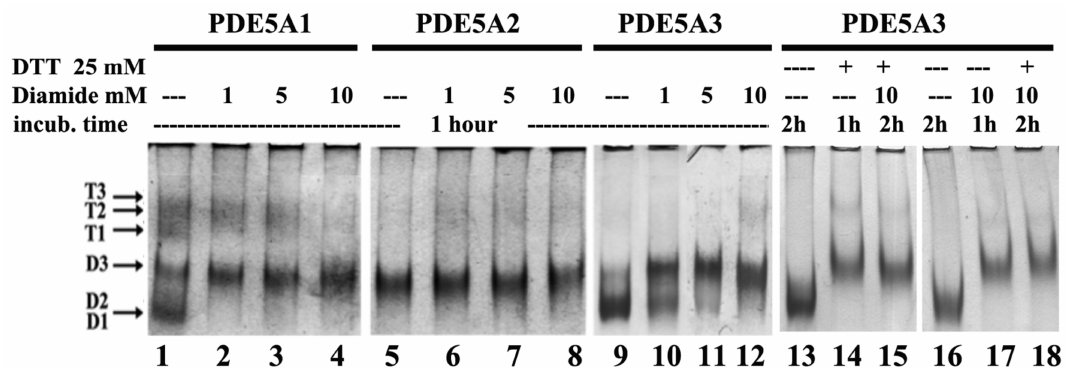
Figure 4. Migration mobility of PDE5 isoforms in native PAGE after incubation for 1 h at 30 ◦ C in the presence of increasing concentrations of either diamide or diamide and DTT (or the opposite order) added in succession after 1 h and incubated for one more hour. Each lane contained 1 µ g of purified MmPDE5A1, A2 and A3. Proteins were visualized through Coomassie